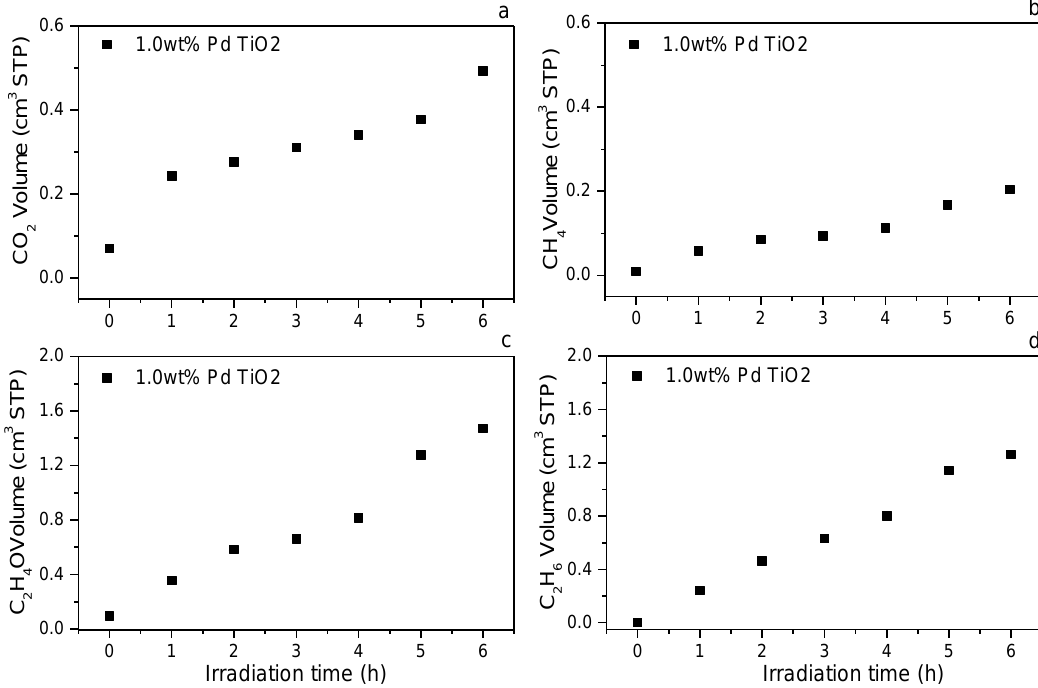
Figure 10. Hydrocarbon profiles of ( a ) carbon dioxide (CO 2 ), ( b ) methane (CH 4 ), ( c ) acetaldehyde (C 2 H 4 O) and ( d ) ethane (C 2 H 6 ) at 1.00 wt% Pd. Conditions: Photocatalyst concentration 0.15g/L, 2.0 v/v% ethanol, argon atmosphere, pH = 4 ± 0.05 and near-UV light. Standard deviation: (a) ±4.1%, (b) ±4.7%, (c) ±5.1%, (d) ±6.3%.